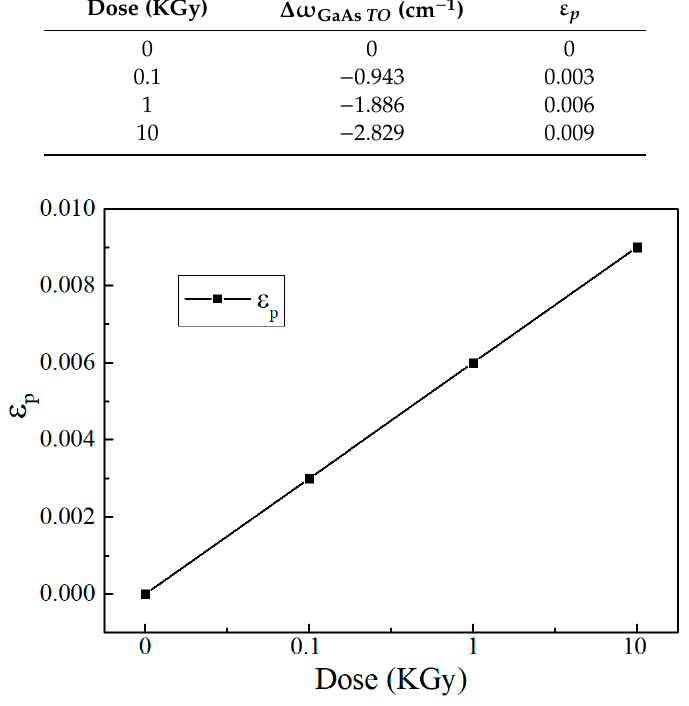
Figure 4. The variation of lattice strain ( ε (cid:3043) ) of GaAs as function of gamma dose.